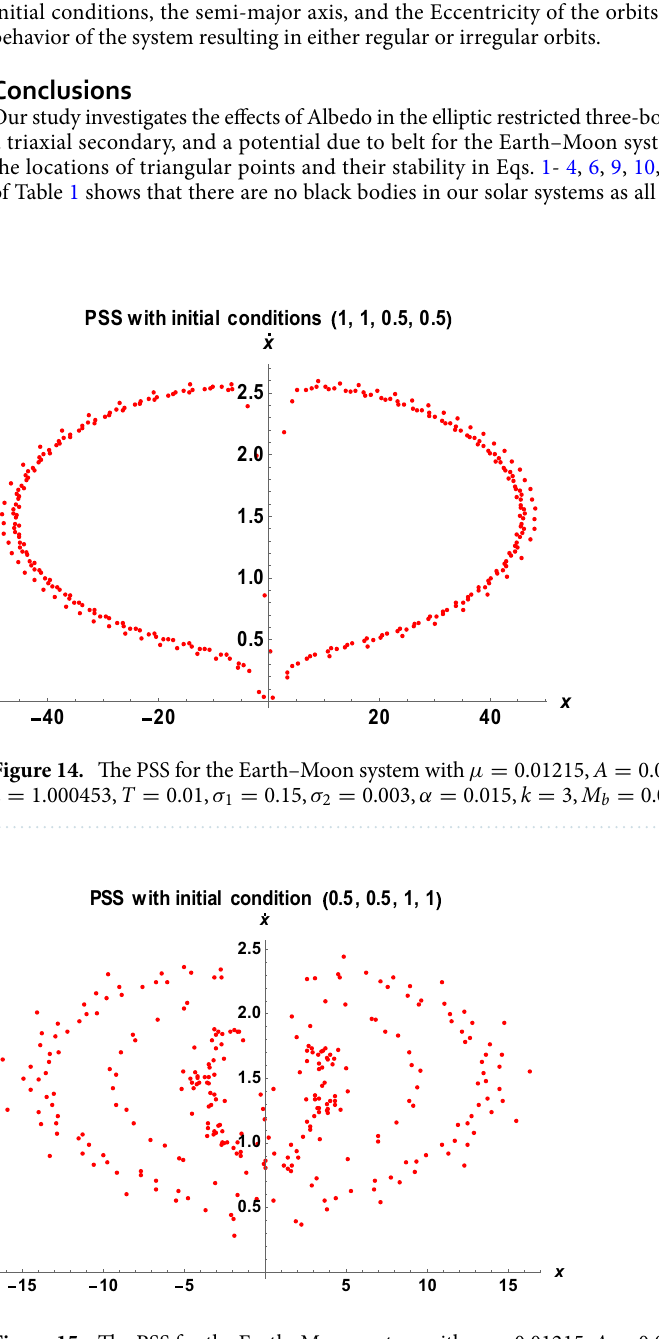
Figure 15. The PSS for the Earth–Moon system with µ = 0.01215, A = 0.0000003686, e = 0.0549, a = 1.000453, T = 0.01, σ 1 = 0.25, σ 2 = 0.005, α = 0.025, k = 5, M b = 0.05